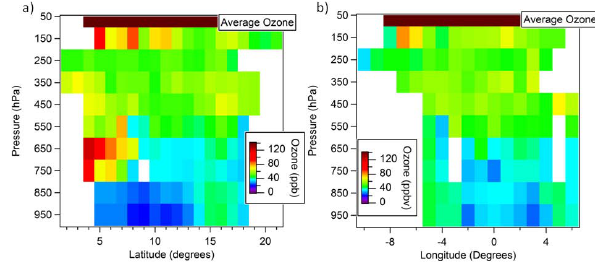
Fig. 3. Average ozone concentrations in bins of 100hPa of atmo- spheric pressure and (a) 1 degree of latitude and (b) 1 degree of longitude based on 1-min data from the BAe-146, the DLR Falcon, the French Falcon, French ATR and the M55 between 20 July and 21 August. Note that the ozone concentrations in the top layer are averages between of 100 and 50hPa and are off the colour scale, extending up to 1700ppbv.